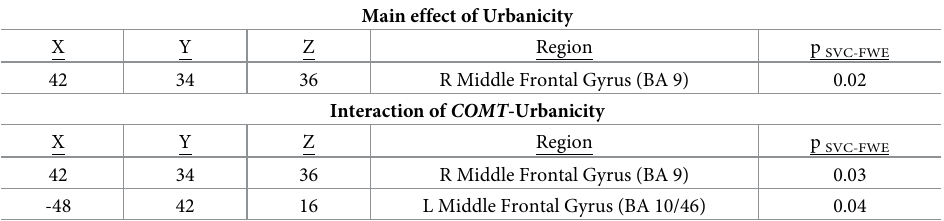
Table 4. Main effect of urbanicity and COMT -urbanicity interaction: Italian replication (n = 226).